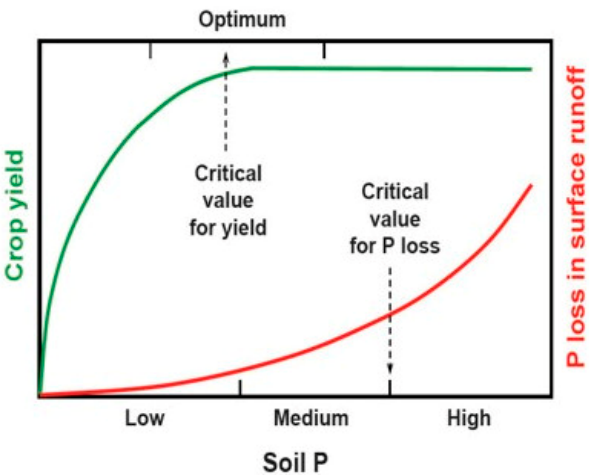
Figure 4. Theory behind the critical values of extractable soil P, determining optimal yield, beyond which, surplus and potential loss via surface runoff occur. Source: https://water.unl.edu/phospho- rus-dynamics (24 October